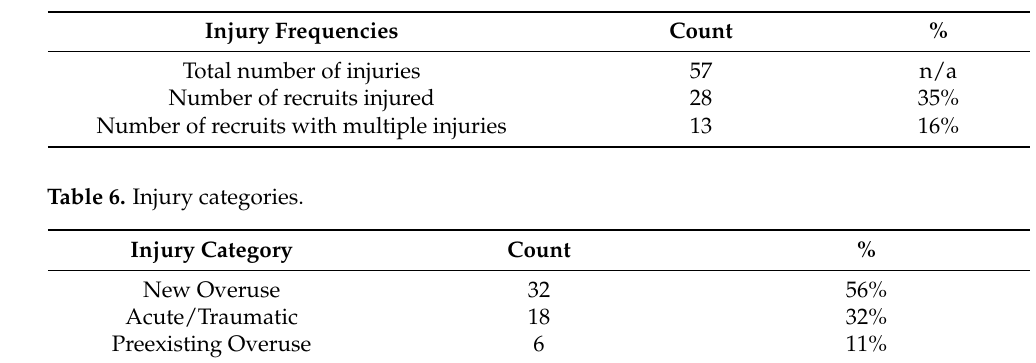
Table 5. Injury frequencies.